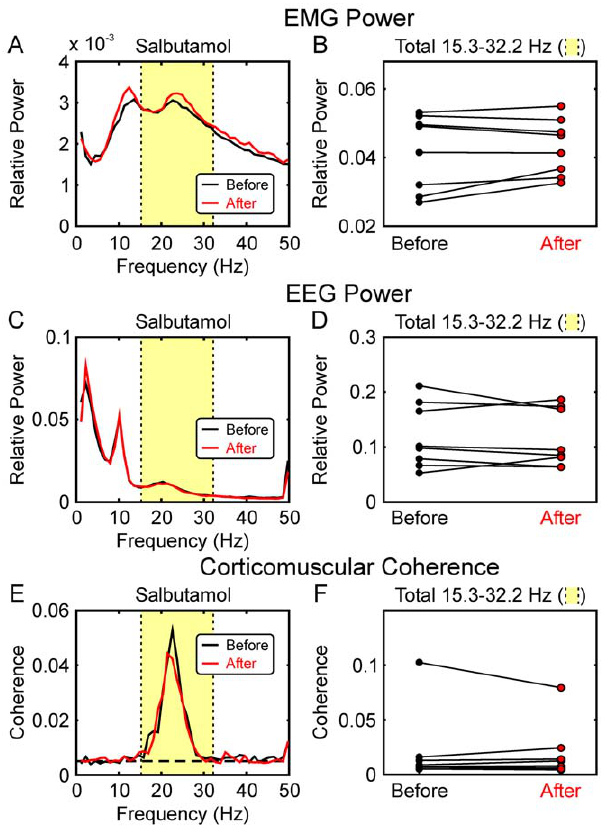
Figure 5. Effects of Salbutamol on Beta-band Oscillations during the Auxotonic Precision Grip Task. A, EMG power spectrum, averaged over all five muscles and eight subjects, before and after administration of salbutamol. B, total power in the 15.3– 32.2 Hz band (shaded yellow in A) before and after salbutamol inhalation. Each point gives data from a single subject. C,D, as (A,B), but for EEG power. E,F, as (A,B), but for corticomuscular coherence. Dashed horizontal line in (E) marks the significance limit for the coherence (P , 0.05). None of the measures displayed in (B,D,F) significantly changed after salbutamol administration (P . 0.05).